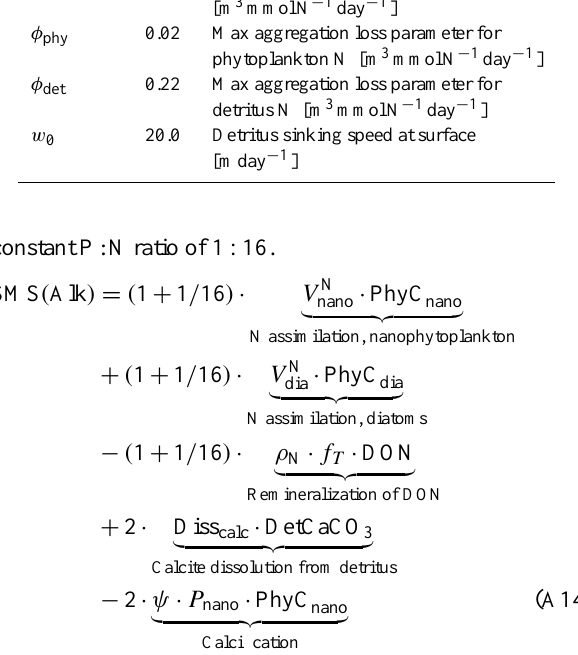
Table A7. Parameters for sources minus sinks equations. Parameter Value Description and unit 0.1 Calcite production ratio, dimensionless Fraction of grazing flux to zooplankton pool, dimensionless